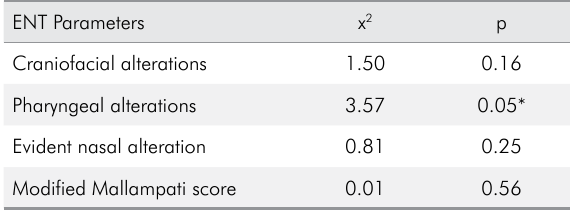
Table 4. ENT parameters for the responders and